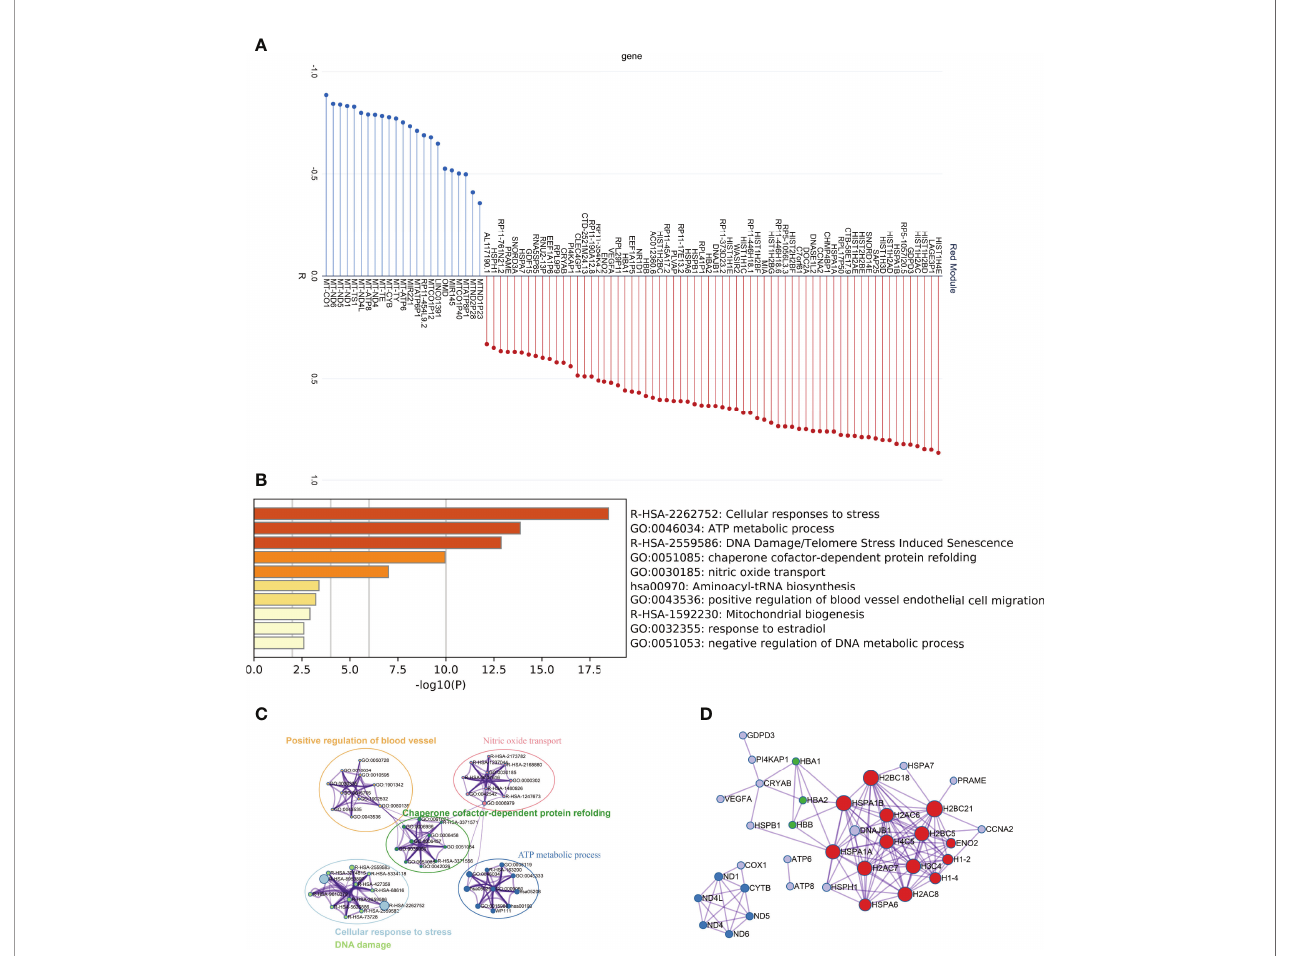
FIGURE 4 | In-depth analysis of the Red module genes. (A) Correlation of Red module genes with the fi rst principal component (B, C) Results of functional enrichment analysis. (D) PPI network and coregulatory